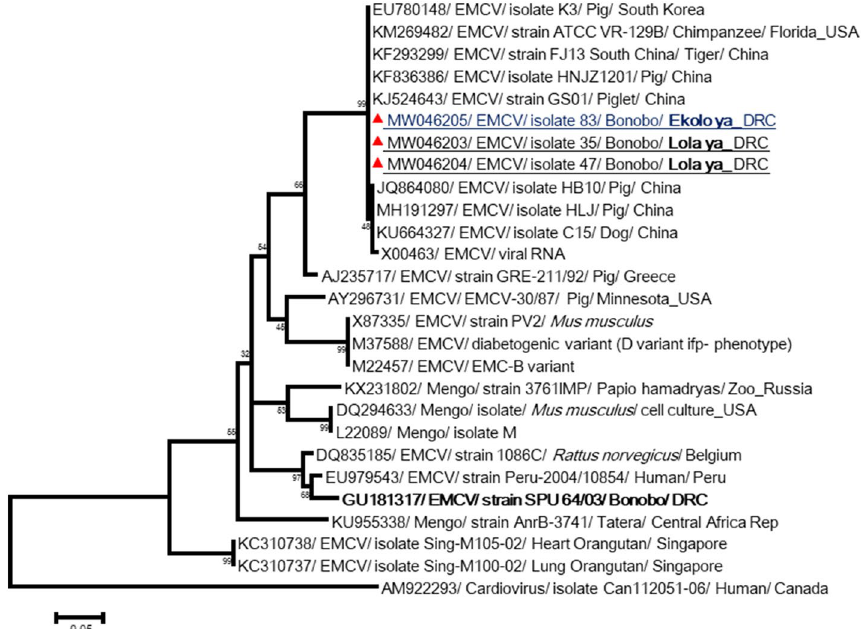
Figure 2. Phylogenetic tree for the partial sequence 3D of the Encephalomyocarditis viruses. The evolutionary history was inferred by using the Maximum Likelihood method based on the Tamura 3-parameter model. Sequences are identified as follows: accession number/virus/strain/host/country. Obtained sequences on samples from wild or semi-captive bonobos were closely identical to each other and to the available sequences in GenBank detected on other mammals (chimpanzee, pigs, tiger, rodents and dog). By contrast, they were distinct from the strain SPU64/03 (in bold), responsible of the fatal epizooty in Lola 25 . The tree is drawn to scale, with branch lengths measured in the number of substitutions per site. The analysis involved 27 nucleotide sequences. All positions containing gaps and missing data were eliminated. There were a total of 228 positions in the final dataset. Evolutionary analyses were conducted in MEGA7 61